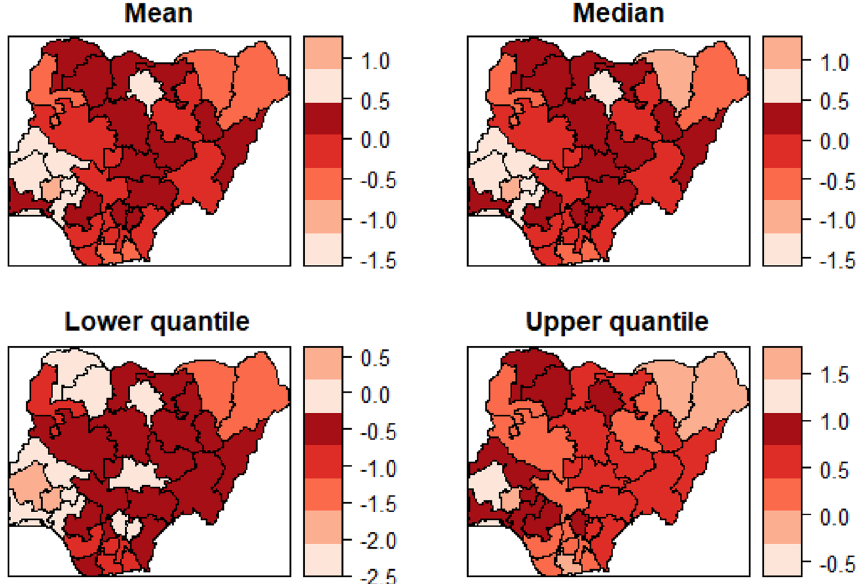
Figure 5. Nigeria state-level e stimated posterior mean of the structured spatial effect maps: (a) Mean, (b) Median, (c) 25% quantile and 97.5% quantile for 2015.